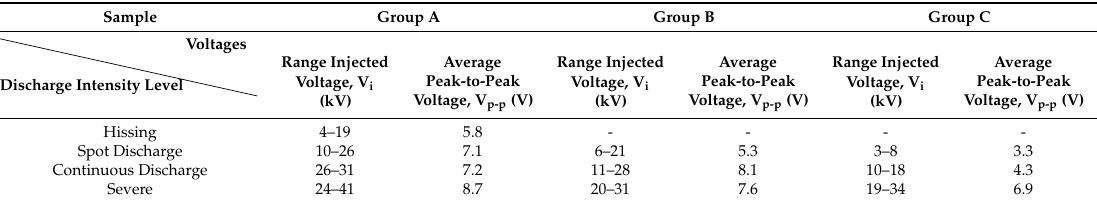
Table 12. Injected voltage and average peak-to-peak voltages of the UV signals for wet insulators conditions with light contamination level.